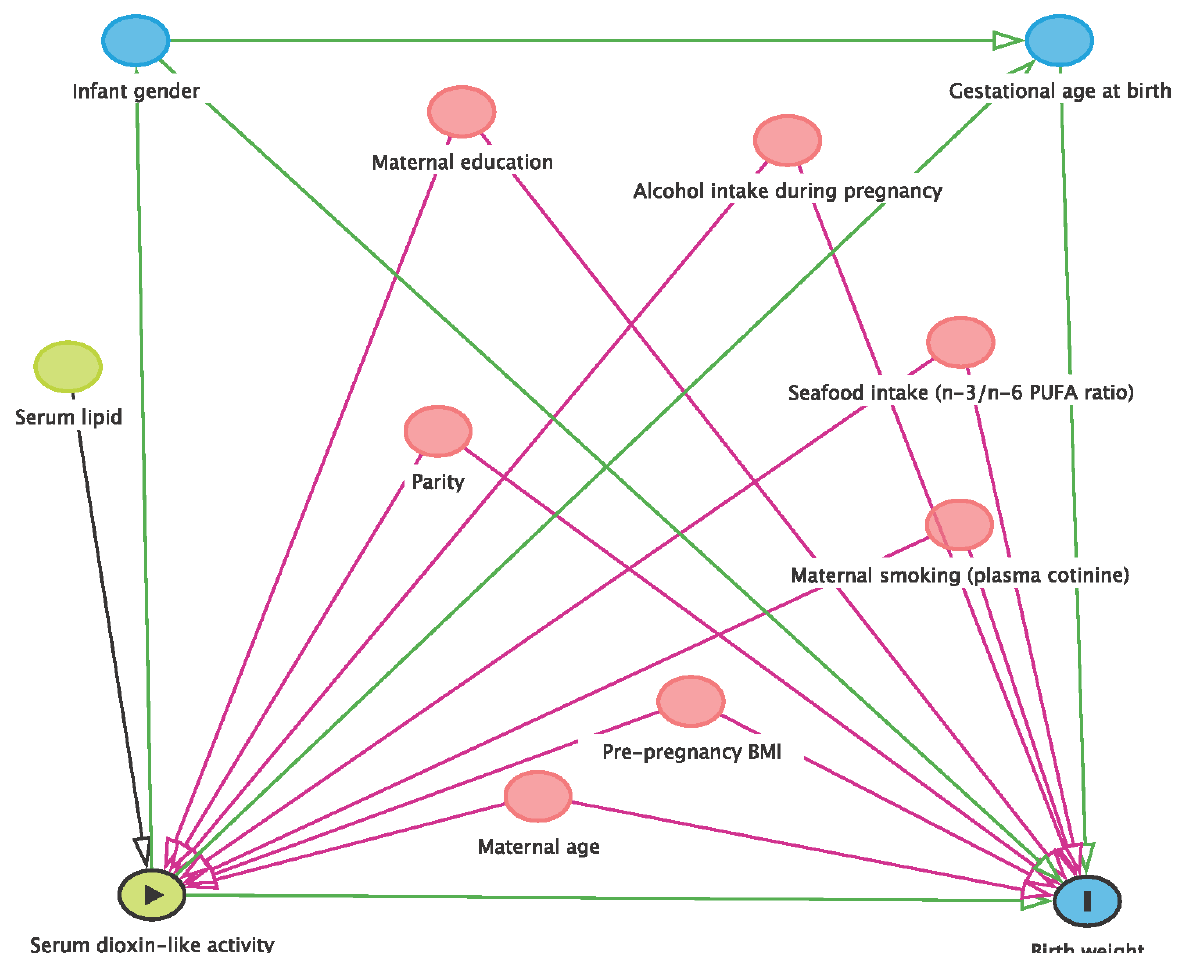
Figure 3. Directed acyclic graph illustrating the potential influences on the relationship between serum dioxin-like activity and birth weight. The figure also applies to other fetal growth indices (birth length, head circumference, ponderal index and gestational age at birth). According to this graph, variables in pink circle were adjusted in the model. The figure was made using dagitty.net [61]